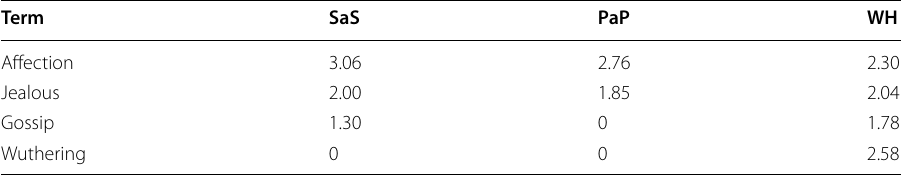
Table 2 Log frequency weight of terms in each of the novels Term